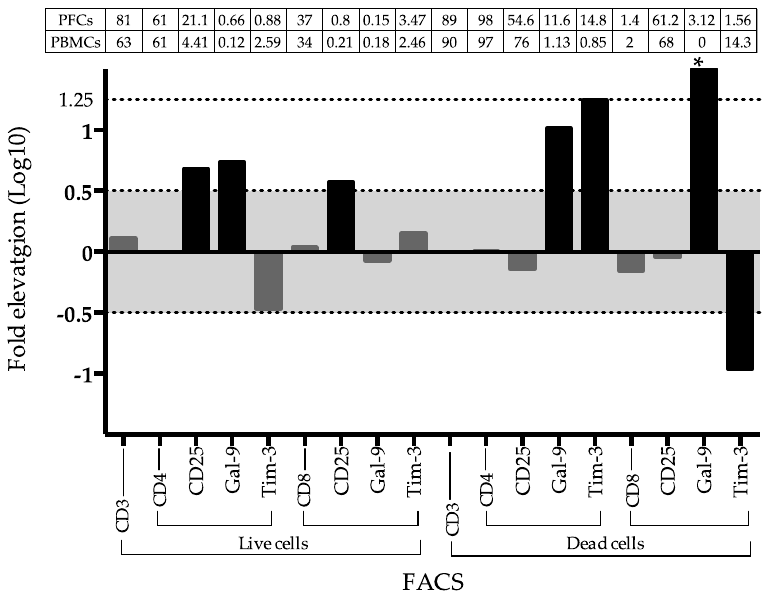
Figure 4. Fluorescence-activated cell sorting (FACS) analysis between PBMCs and PFCs. Fold comparison for the frequency of cells of interest in FACS analysis between PBMCs and FBCs. * indicates infinite as Gal-9 positive expression percentage in dead CD8 T cells from PFCs and PBMCs are 3.12 and 0, respectively. Gates of selection were indicated under x-axis. The absolute percentage of each gated cell group was described in the table above the indicated panel.